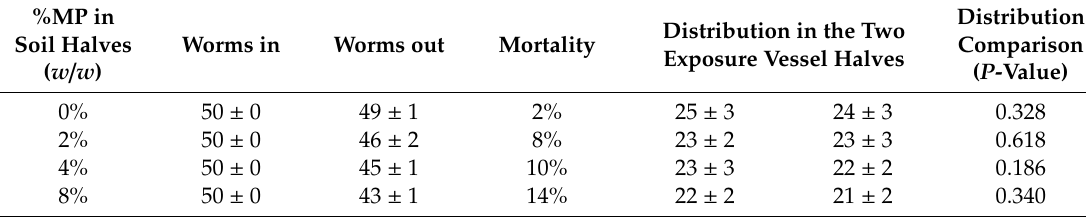
Table 1. Acute toxicity and area preference in pairings with the same percentage of microplastic (MP) in both halves ( n = 15, at 50 worms per independent replicate). Significance was tested by pairwise t-tests after normality and homogeneity tests were